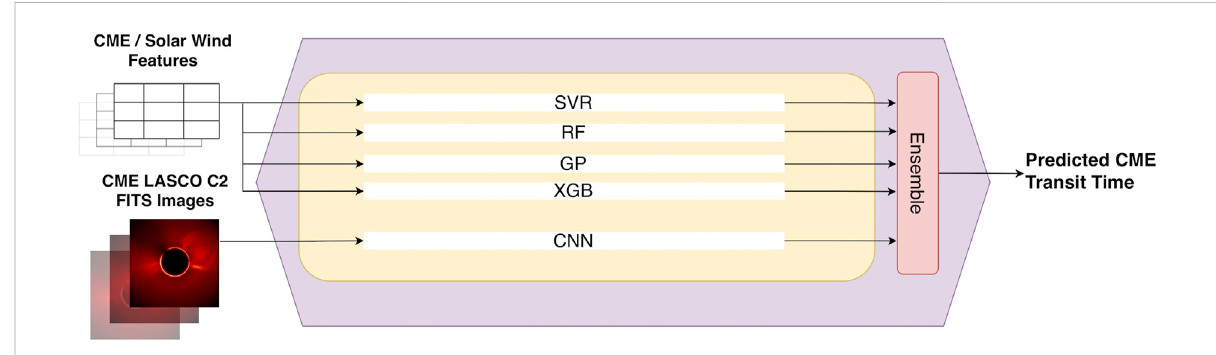
FIGURE 4 IllustrationofourCMETNetframework.Theframeworkconsistsof fi vemachinelearning-basedregressionmodels:SVR,RF,GP,XGBandCNN. For a CME event E , the fi rst four models (SVR, RF, GP, XGB) accept E ’ s CME features and solar wind parameters as input while the fi fth model (CNN) accepts E ’ sCMEimagesas input.The fi veregression modelsare followed byanensemblemethod,whichcombinestheresults fromthe fi vemodels and produces the predicted transit time of E